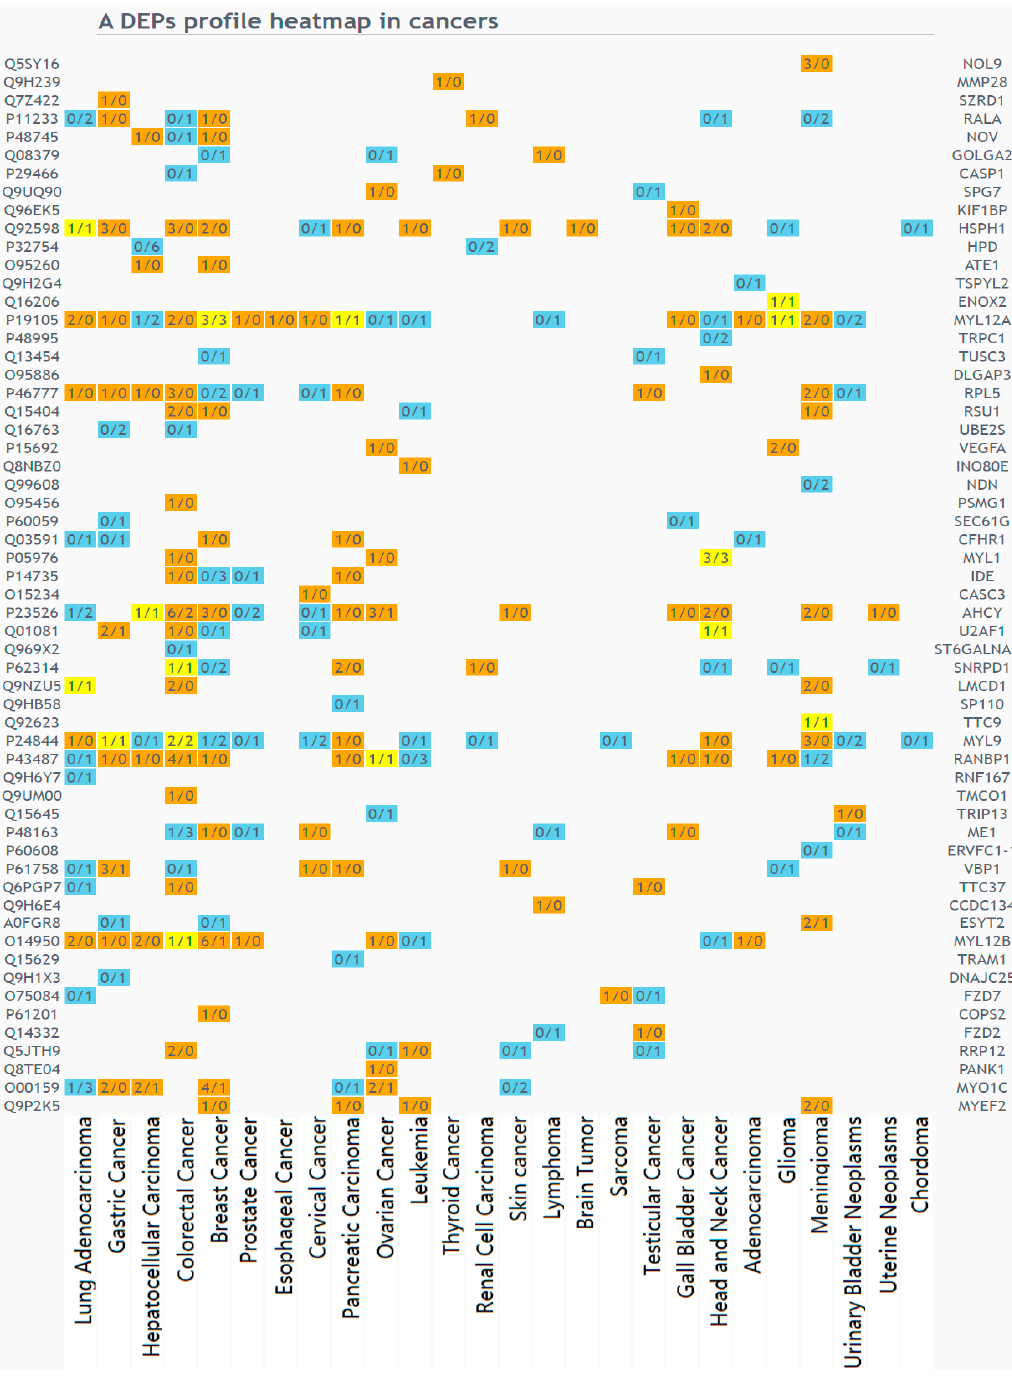
Figure 8. Heat map generated by dbDEPC 3.0 [33] from NPC proteins from BCP blood, associated with different cancer types. Orange means that the number of the studies identified this protein as up-regulated are more than the number of the studies identified the protein as down-regulated; blue means that the number of the studies identified this protein as up-regulated are less than the number of the studies identified protein as down-regulated; yellow means that the number of the studies identified the protein as up-regulated are equal to the number of the studies identified protein as down-regulated.